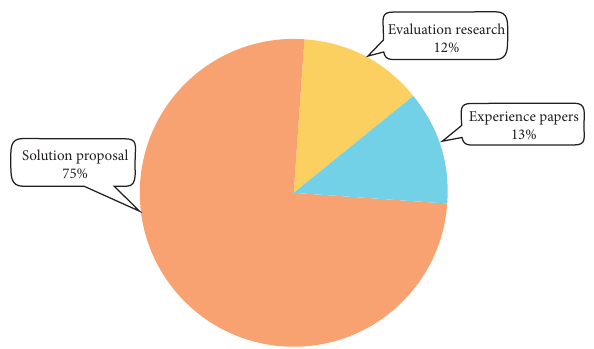
Figure 4: Research type